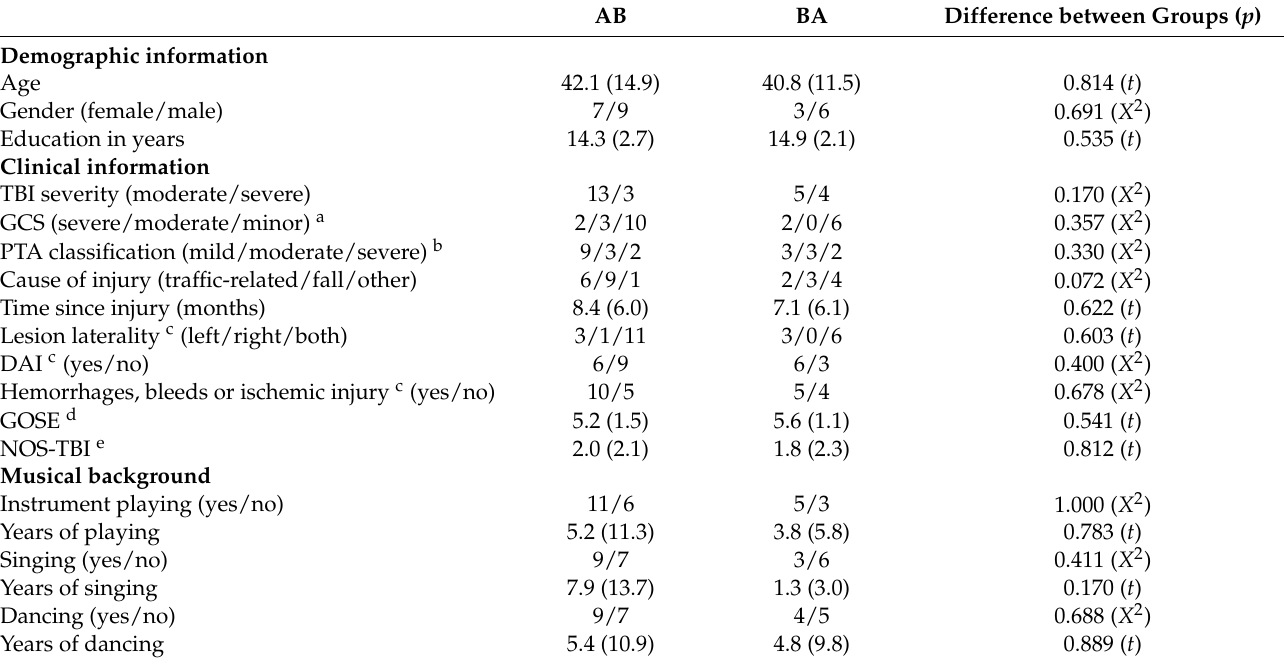
Table 1. Demographic, clinical, and musical background information ( n =